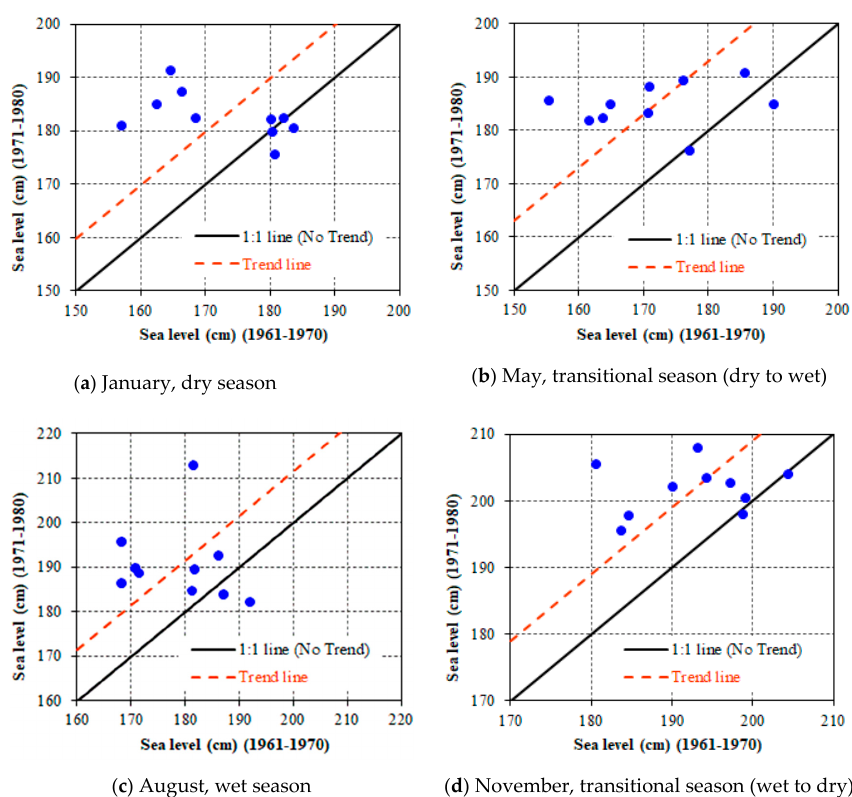
Figure 6. Results of the ITA on monthly sea level in different seasons for the Hon Dau station (1961– 1980).